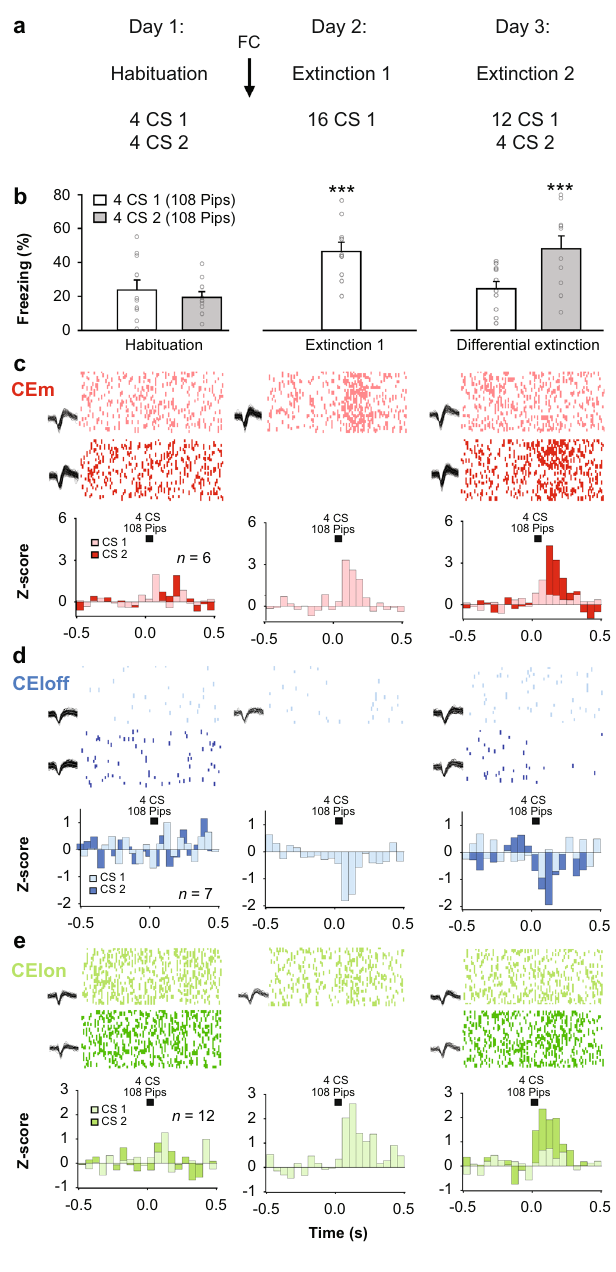
population had signi fi cant z- score values upon CS presentation ( fi rst 4 CSs during diff. extinction 1). Source data are provided as a Source data fi